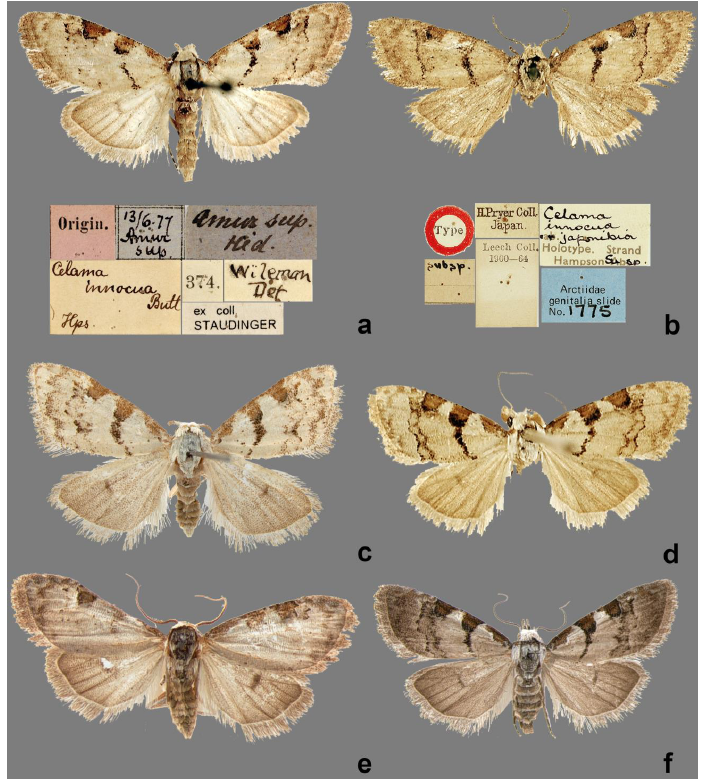
Figure 1. Adult and label illustrations of Nola costimacula Staudinger, 1887: ( a ) N. costimacula , male, holotype, (MfN, gen. slide No. LGN 1226); ( b ) Ditto , female, holotype of Celama innocua var. japonibia Strand, 1920 (NHMUK, Arctiidae genitalia slide No. 1775); ( c ) Ditto , male, (INU, gen. slide No. INU-12308); ( d ) Ditto , female, identified as Nola japonibia ex coll. Inoue (NHMUK, Arctiidae genitalia slide No. 1818); ( e ) Ditto , male, (INU, gen. slide No. INU-11537); ( f ) Ditto , female, (INU, gen. slide No.